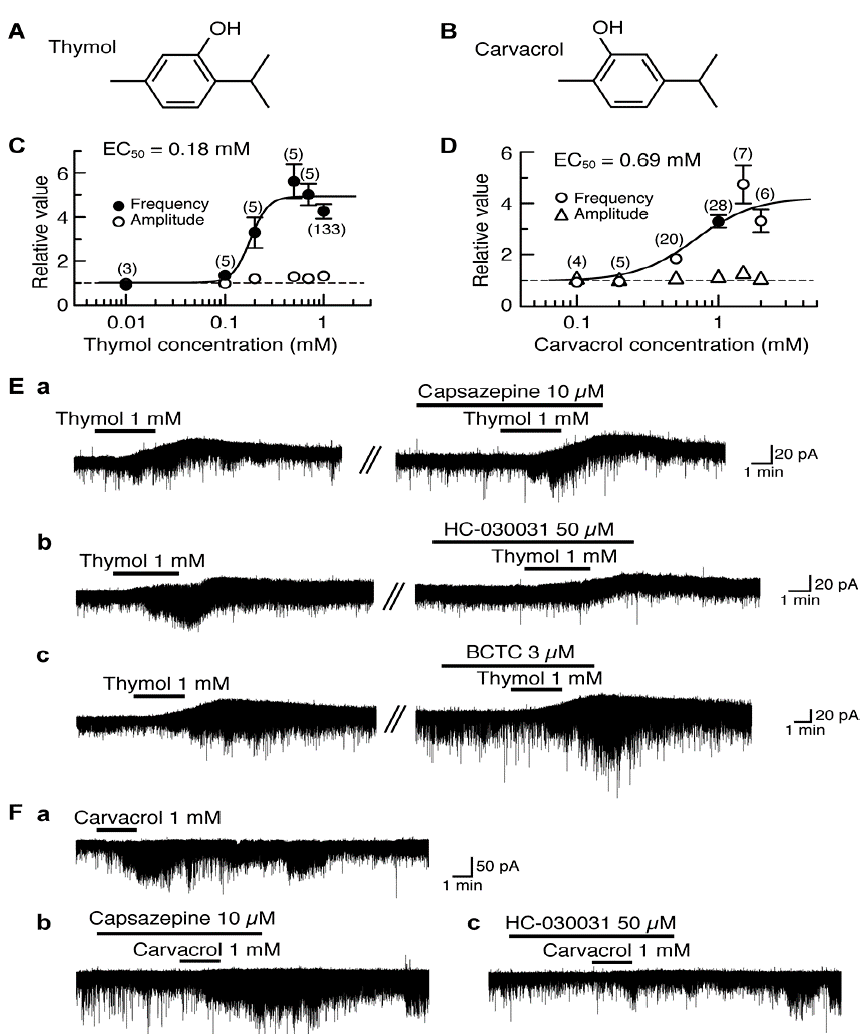
Figure 1. Effects of thymol and carvacrol on glutamatergic spontaneous excitatory transmission in rat substantia gelatinosa (SG) neurons. ( A , B ) The chemical structures of thymol ( A ) and carvacrol ( B ). ( C , D ) The frequency and amplitude of sEPSC under the action of thymol ( C ) or carvacrol ( D ), relative to those before drug superfusion, which were plotted against the logarithm of drug concentration. This thymol (carvacrol) effect was measured for 0.5 min around 5 min (3.5 min) after the beginning of its superfusion. The results in ( C ) were obtained from all neurons tested, while those in ( D ) were obtained from neurons where carvacrol (1 mM) increased sEPSC frequency > 5%. The continuous curves in ( C ) and ( D ) were drawn according to the Hill equation [half-maximal effective concentration (EC 50 ) and Hill coefficient (n H ) in ( C ) and ( D ): 0.18 mM, 4.9 and 0.69 mM, 2.1, respectively]. ( Ea – c ) Chart recordings showing sEPSCs and holding currents in the absence and presence of thymol in Krebs solution without (left) or with a TRPV1 antagonist capsazepine ( Ea ), a TRPA1 antagonist HC-030031 ( Eb ) or a TRPM8 antagonist BCTC ( Ec ; right). In each of ( Ea – c ), the right recording was obtained about 30 min after the left one from the same neuron. ( Fa – c ) Chart recordings showing sEPSCs in the absence and presence of carvacrol in Krebs solution without ( Fa ) and with capsazepine ( Fb ) or HC-030031 ( Fc ); these recordings were obtained from the same neuron at an interval of 30 min. In this and subsequent figures, value in parentheses indicates the number of neurons tested; each point with vertical bars represents the mean values and standard error of the mean (SEM); if the SEM of the values is less than the size of symbol, the vertical bar is not shown; control level (1) is indicated by horizontal dotted line; the duration of drug superfusion is shown by a horizontal bar above the chart recording. Holding potential (V H ) = − 70 mV. This research was originally published in [88] and [89].